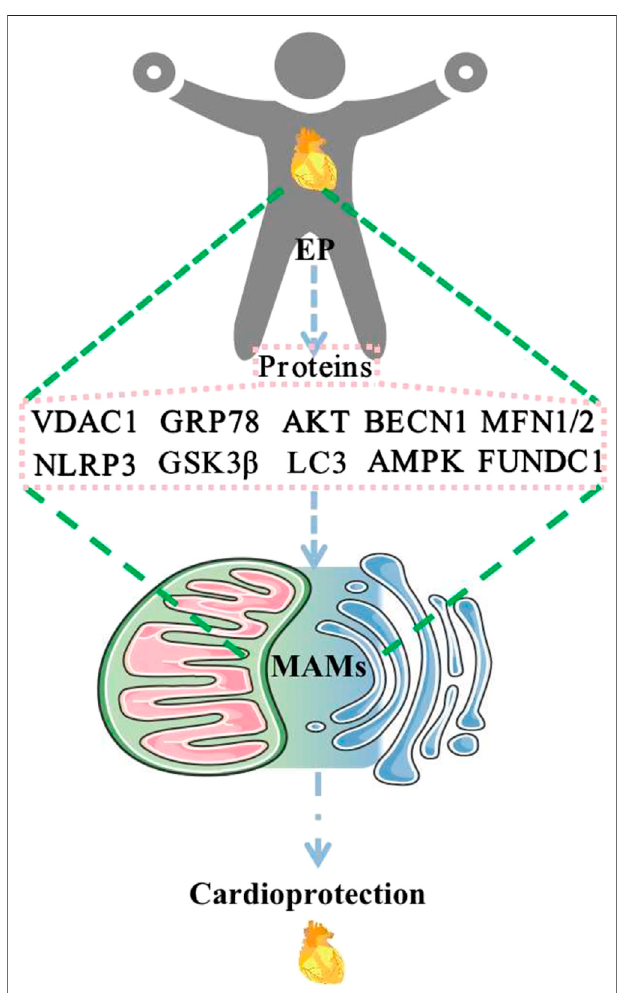
FIGURE 2 | EP regulates MAM-related proteins to promote cardioprotection. Abbreviations: EP, exercise preconditioning; MAMs, mitochondria-associated endoplasmic reticulum membranes; VDAC1, voltage-dependent anion channel 1; GRP78, glucose-regulated protein 78; AKT, protein kinase B; BECN1, beclin1; MFN1/2, mitofusin 1/2; NLRP3, NOD-like receptor protein 3; GSK3 β , glycogen synthase kinase-3 beta; LC3, microtubule-associated protein 1 light chain 3; AMPK, AMP-activated protein kinase; FUNDC1, FUN14 domain containing 1.